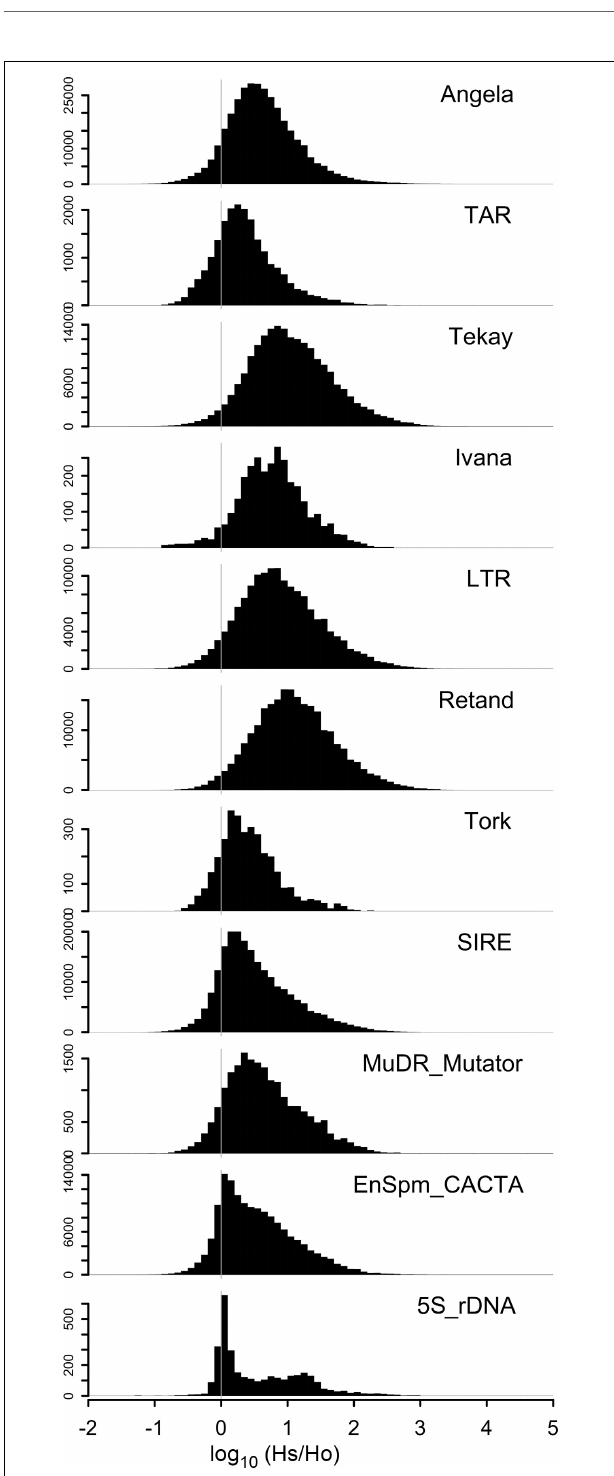
FIGURE 3 | Global variability of main repeat types and their sequence conservation across the Loliinae genome landscapes. Histograms show distributions of read similarity Hs/Ho hit ratios [frequencies of read similarity hits to reads from the same species (Hs) or to reads from all other species (Ho) (log scale, x -axis) and number of reads ( y -axis)]. Hs/Ho ratios close to one (0 on the logarithmic scale) indicate sequence conservatism while larger values indicate sequence